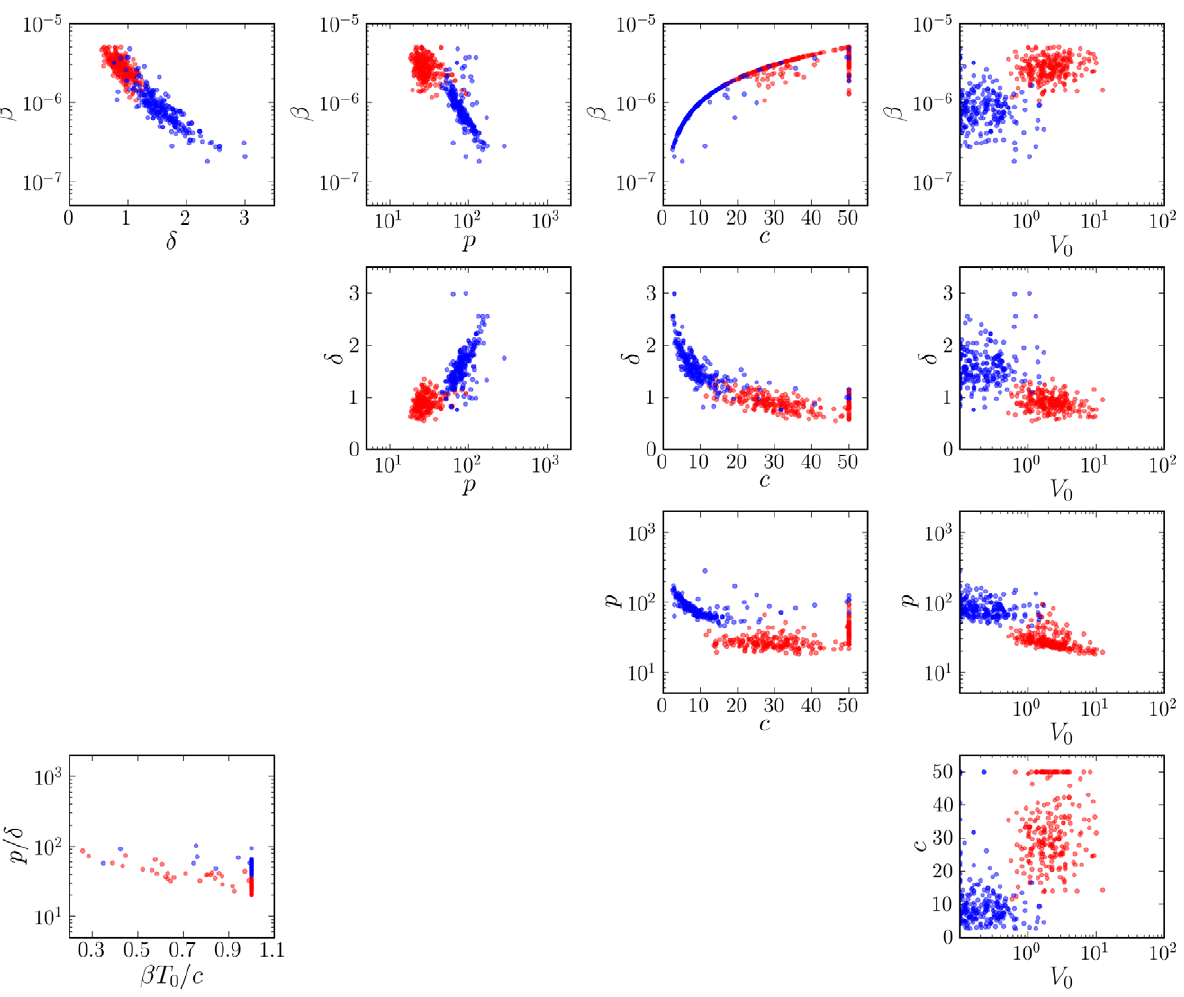
Figure 5. Parameter ensembles from bootstrap fits of the viral kinetic model. Plots of the parameters, in the form of two parameter projections of each fit, and the constraints (bottom left) from bootstrap fits of the viral kinetic model (Equations (4)–(7)) to lung titers from mice infected with PR8 (red) or PR8-PB1-F2(1918) (blue).